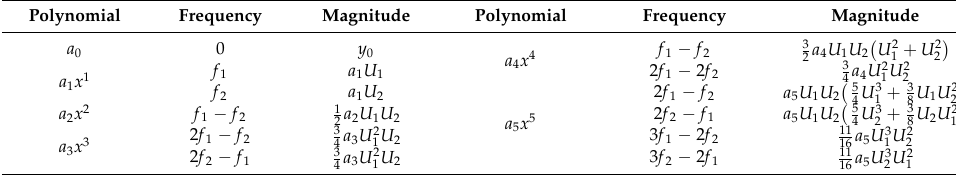
Table 1. System output signal amplitude ( i =